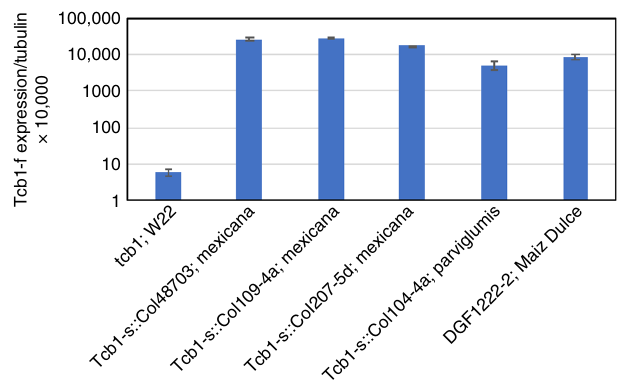
Fig. 4 Mean expression of Tcb1-f/PME38 in lines with different Tcb1-s haplotypes. W22 is a standard maize tcb1 line, Tcb1-s::Col48703 , Tcb1-s:: Col109-4a , and Tcb1-s::Col207-5d are three independent collections of Zea mays ssp. mexicana tesointe lines; Tcb1-s::Col104-4a , a Zea mays ssp. parviglumis line; and DGF1222-2 derived from Maiz Dulce, an ancient Mexican maize sweet corn variety 8 . Error bars equal the standard error of the mean. Source data for RT-PCR are provided as a Source Data fi